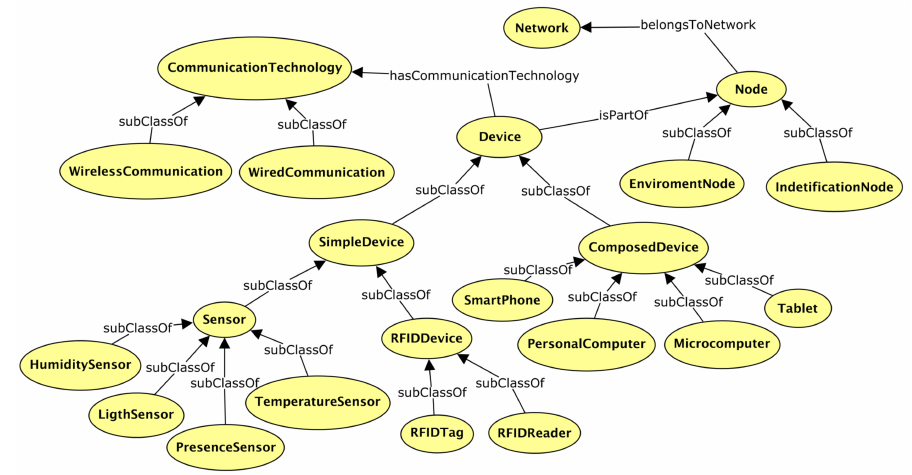
Figure 4. Network ontology.